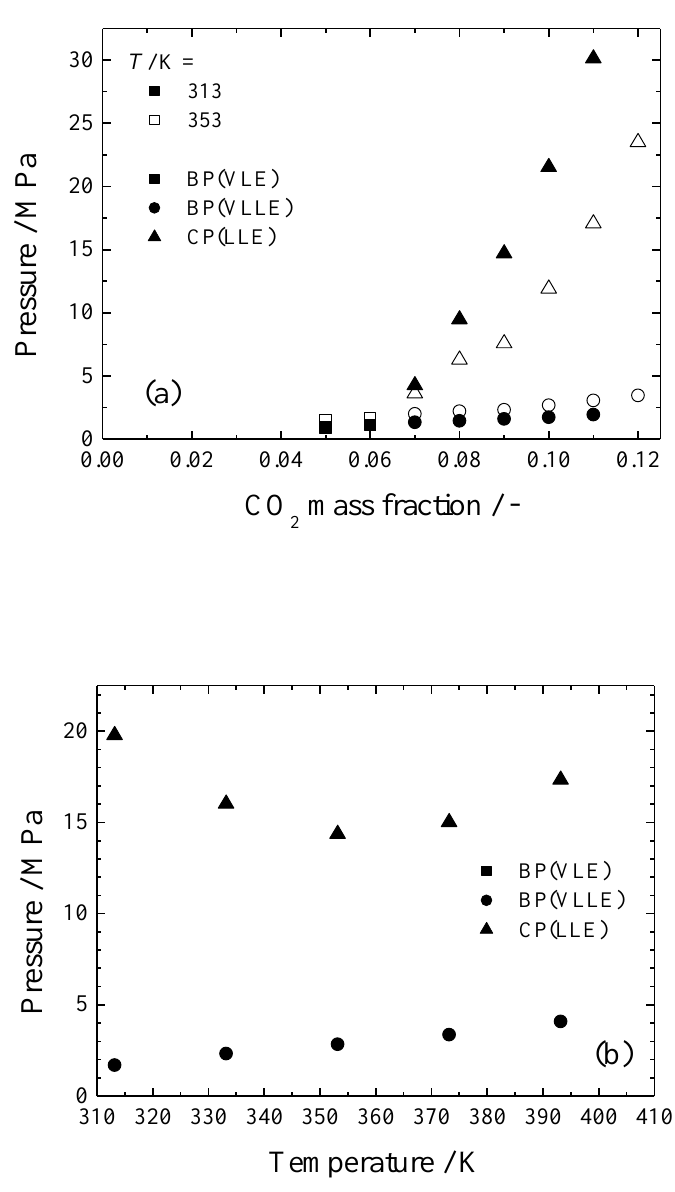
Figure 4. Effect of the temperature on the phase behavior of a CO 2 /MTMS/PS ternary system (M W = 35,000, MTMS:PS = 9:1). ( a ) Pressure-CO 2 mass fraction phase diagram. ( b ) Pressure-temperature phase diagram ( m 1 = 0.094, m 2 = 0.814, m 3 = 0.091).